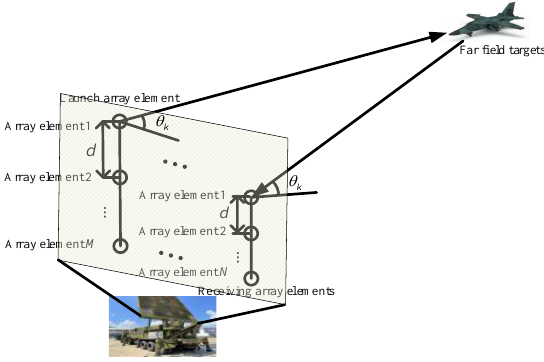
Figure 1. Schematic diagram of the MIMO radar architecture.